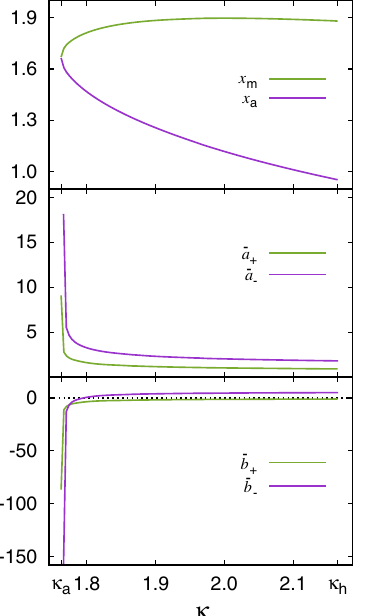
√ 2 Λ m • . This domain